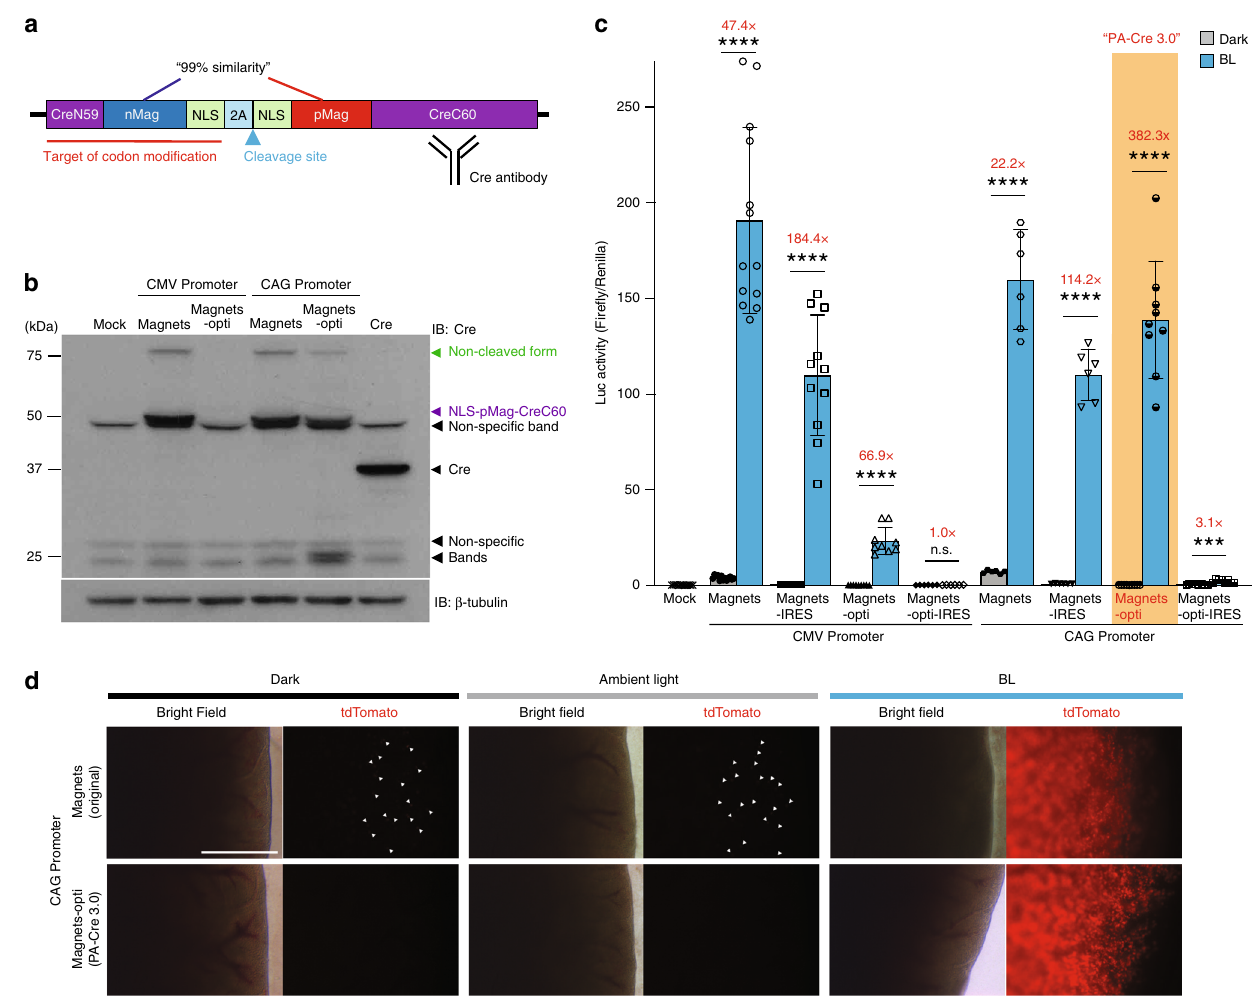
Fig. 2 Development and characterization of PA-Cre 3.0. a Schematic representation of PA-Cre components indicating codon modi fi cation site, 2A cleavage site and Cre antibody recognition site. b Representative western blotting images to compare CMV and CAG promoters for testing Magnets and Magnets codon-optimized PA-Cre (Magnets-opti). All protein expressions were accomplished in the dark condition (single independent experiments). c Comparisons of the original Magnets- and Magnets-opti-based PA-Cre using CMV or CAG promoter with 2A or IRES sequences (Magnets-IRES, Magnets-opti-IRES) using dual Luc assay. Luc assays were conducted in HEK 293T with double- fl oxed inverted Fluc. The upper diagram shows an illumination protocol used for the assays (blue LED, 447.5 nm, 8.28 W/m 2 , repeated 20 s light and 60 s dark for 12 h) (n.s. not signi fi cant, *** P ≦ 0.0005; **** P < 0.0001; dark v.s. BL using Two-tailed t test, Biologically independent samples; Mock, CMV-Magnets: n = 13, CMV-Magnets-IRES n = 11, CMV- Magnets-opti n = 9, CMV-Magnets-opti-IRES, CAG-Magnets, CAG-Magnets-IRES: n = 6, CAG-Magnets-opti n = 9, CAG-Magnets-opti-IRES2 n = 8, mean ± s.d.). Red values show fold induction of Luc with BL compared with dark. d Comparison of CAG-driven Magnets-opti-based PA-Cre (PA-Cre 3.0) with the original version of PA-Cre (Magnets-based) using fl uorescence imaging in mouse livers in vivo. Fluorescence liver imaging of tdTomato expression was conducted in Rosa26 Ai14/WT (Ai14: Floxed-tdTomato heterozygote) live mice transiently injected with CAG-Magnets or CAG-Magnets-opti plasmids, respectively in the dark, ambient light and under blue-light illumination (470 ± 20 nm, 200 W/m 2 , 16 h continuous) ( n = 2 – 6 mice/group, Scale bar: 1 mm). White arrowheads show tdTomato-positive cells in the livers in the dark and ambient light conditions. Source data are provided as a Source Data